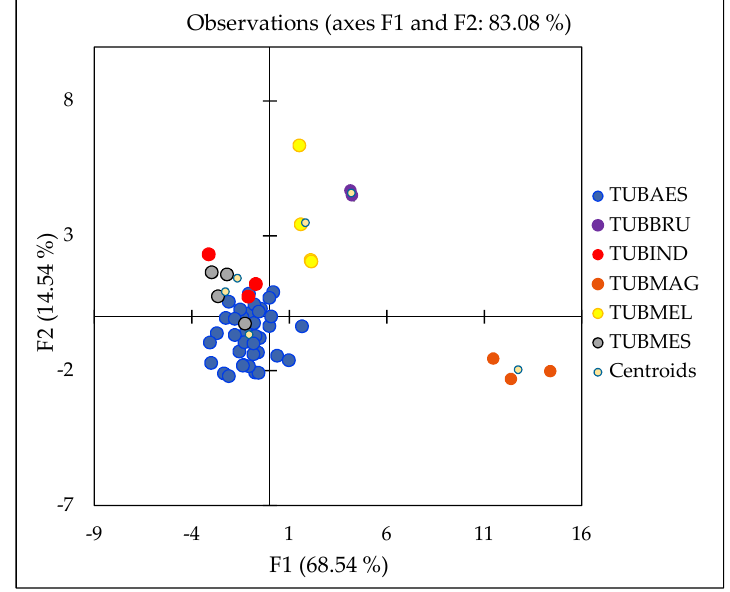
Figure 8. Projection of discriminant analysis (DA) of different truffle species: TUBAES ( T. aestivum ), TUBBRU ( T. brumale ), TUBIND ( T. indicum ), TUBMAG ( T. magnatum ), TUBMEL ( T. melanosporum ), and TUBMES ( T. mesentericum ).